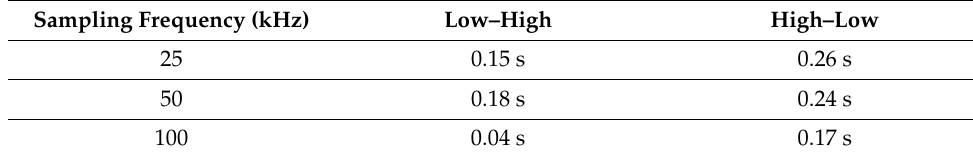
Table 5. Speed response corresponding to the change in